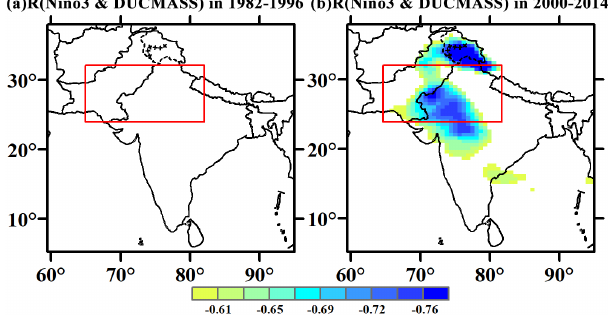
Figure 2. Correlation between the Niño-3 index and DUCMASS over South Asia during (a) 1982–1996 and (b) 2000–2014. (Only correlations that passed the 99% confidence level were